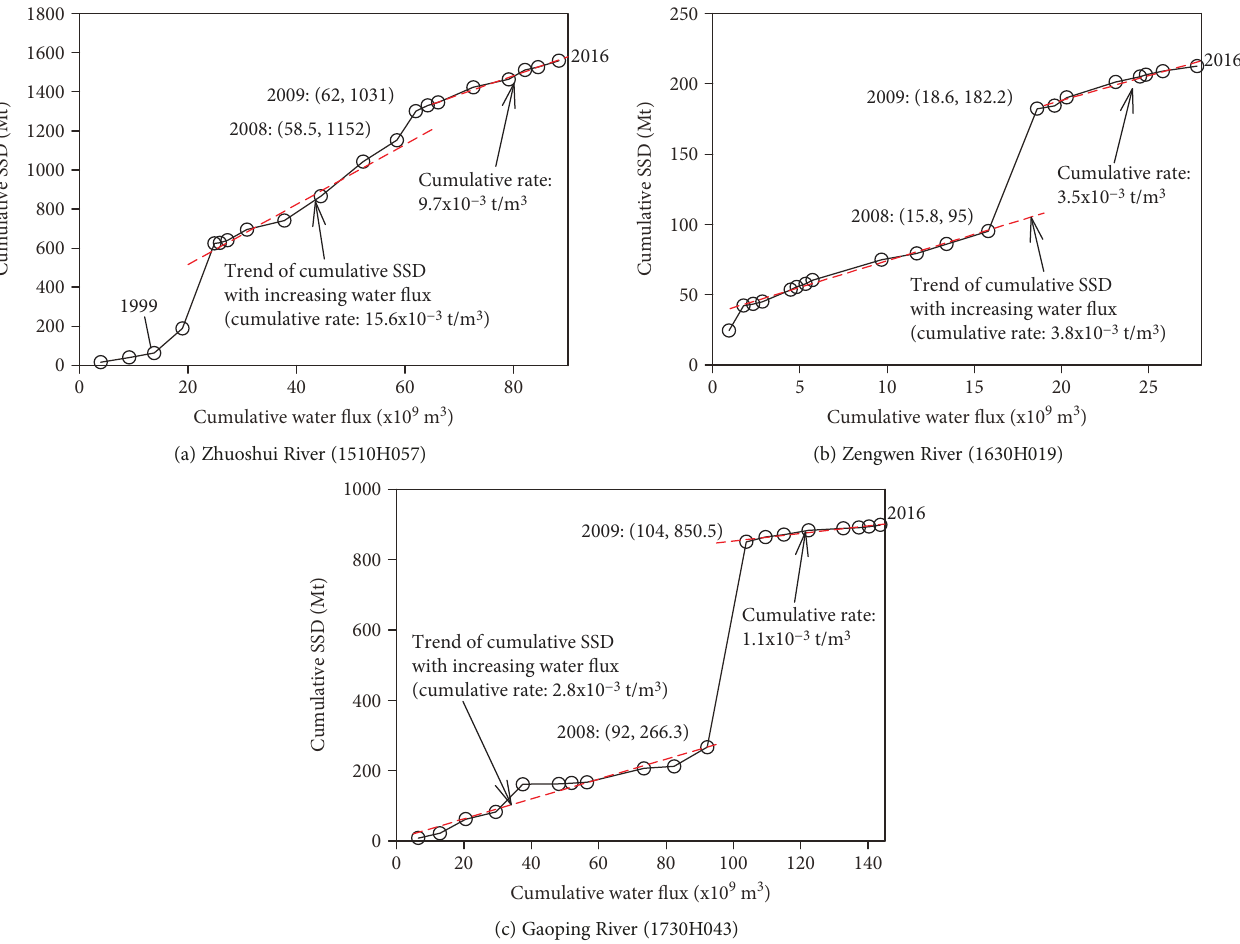
Figure 3: Cumulative water fl ux and SSD in (a) the Zhuoshui River, (b) the Zengwen River, and (c) the Gaoping River in the period from 1997 to 2016. Table 1: Statistics of SSD in the three